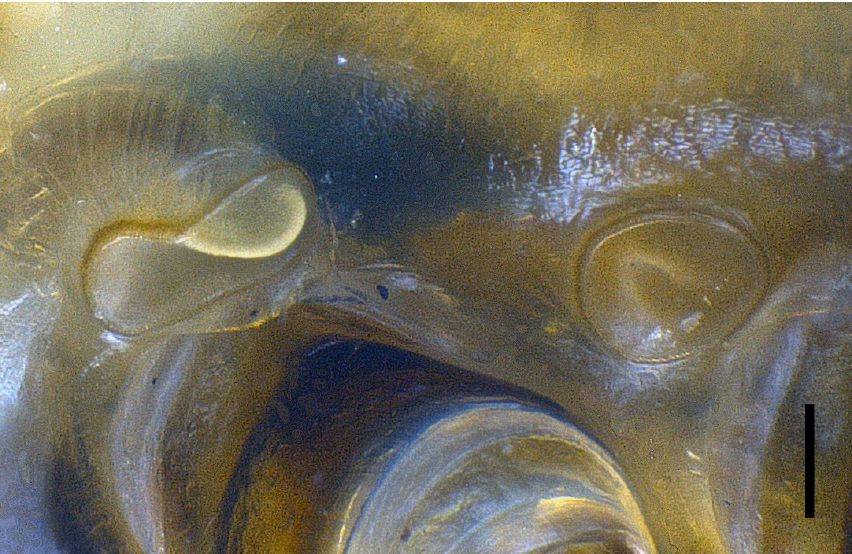
Fig. 25. Pogonosternum montanum Decker, sp. nov., ♂, paratype, spiracles, midbody ring, left lateral side (NMV K-12184). Scale bar: 0.1